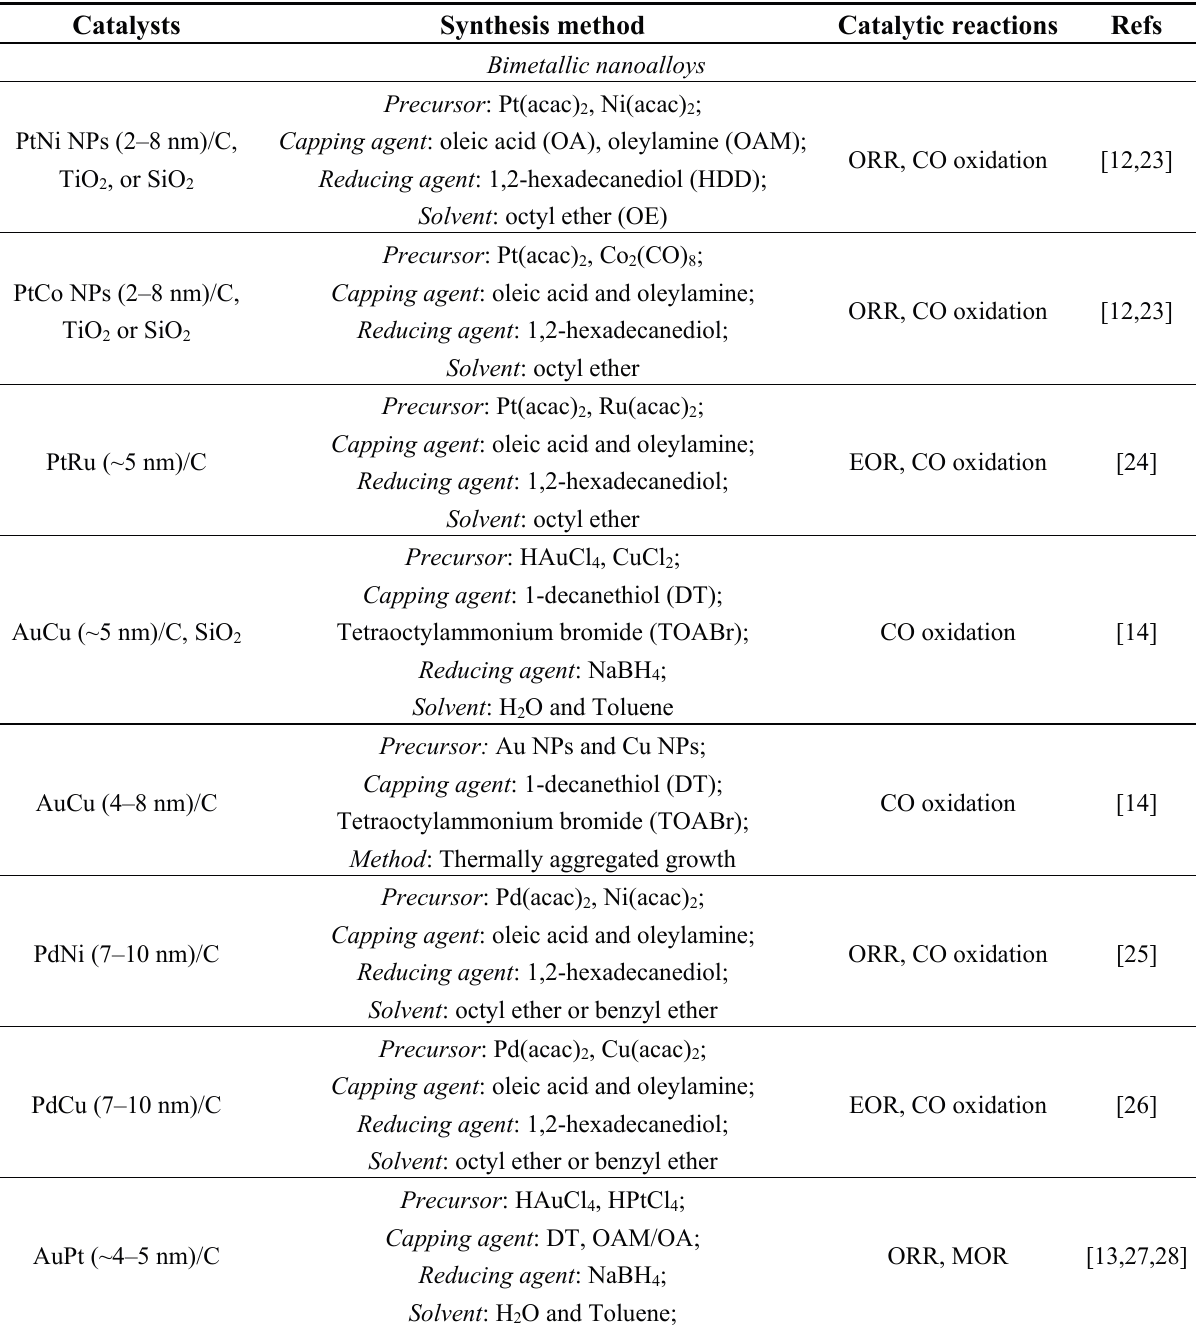
Table 1. Examples of alloy nanoparticles and catalysts prepared by molecularly-mediated synthesis and thermochemical processing